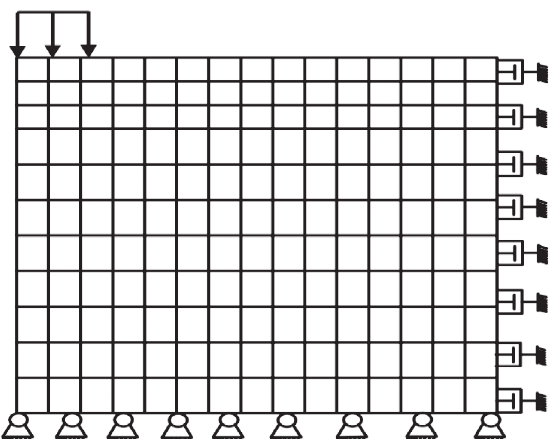
Figure 1: Finite element model of the pavement structure.